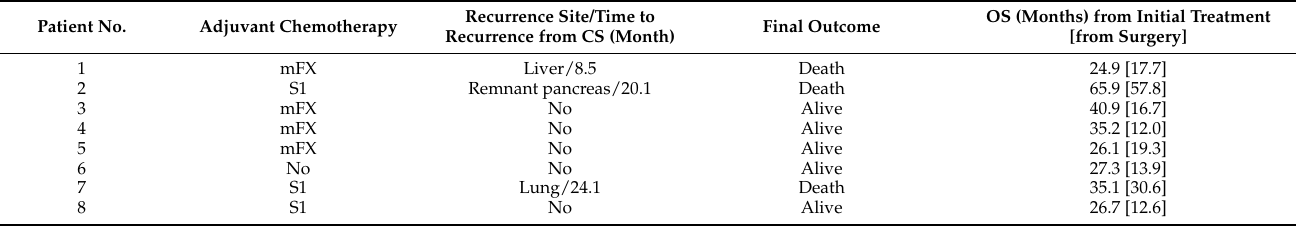
Table 5. Adjuvant Chemotherapy and postoperative